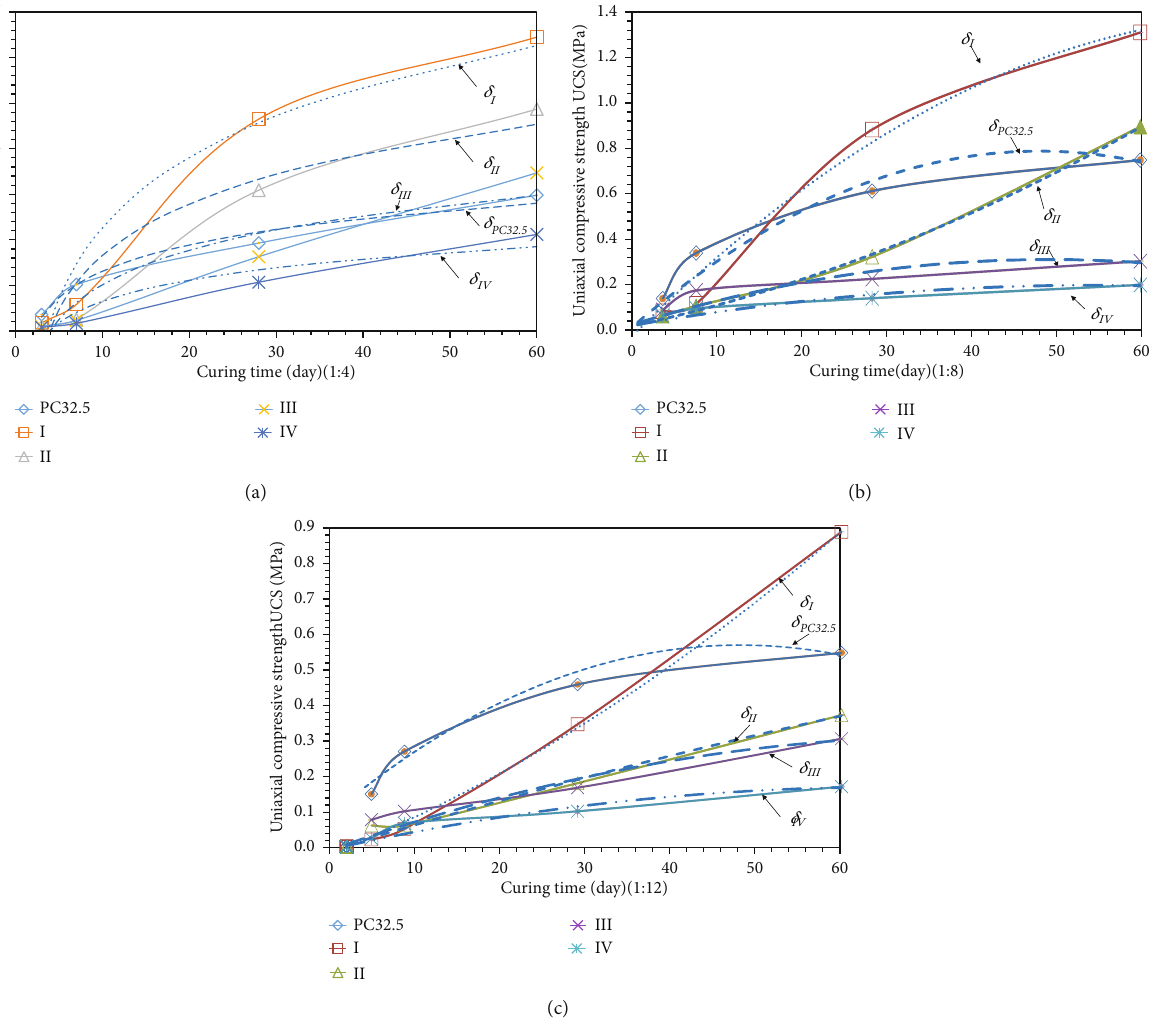
Figure 4: Strength change curve of paste back fi ll in di ff erent curing